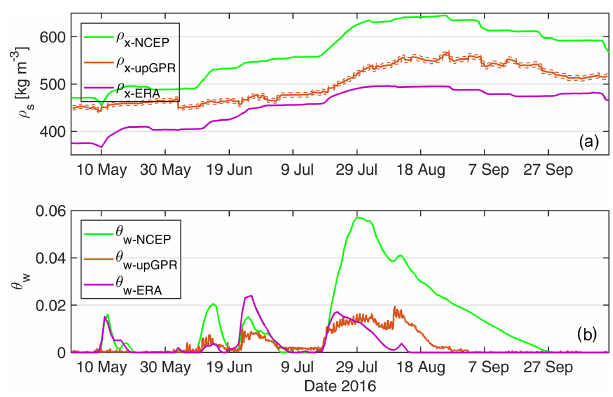
Figure 8. (a) Seasonal changes in bulk density ( ρ x ) for layer L x simulated by MAR with NCEP1 and ERA-Interim forcing com- pared with ρ x derived from upGPR data (brown line with uncer- tainty range). (b) Seasonal changes in θ w for the same layer L x simulated by MAR with forcing NCEP1 and ERA-Interim com- pared with θ w values from radar data (brown line). For bulk density in (a) as well as bulk liquid water content in (b) upGPR data has a temporal resolution of 30min maximum, while MAR has daily values as